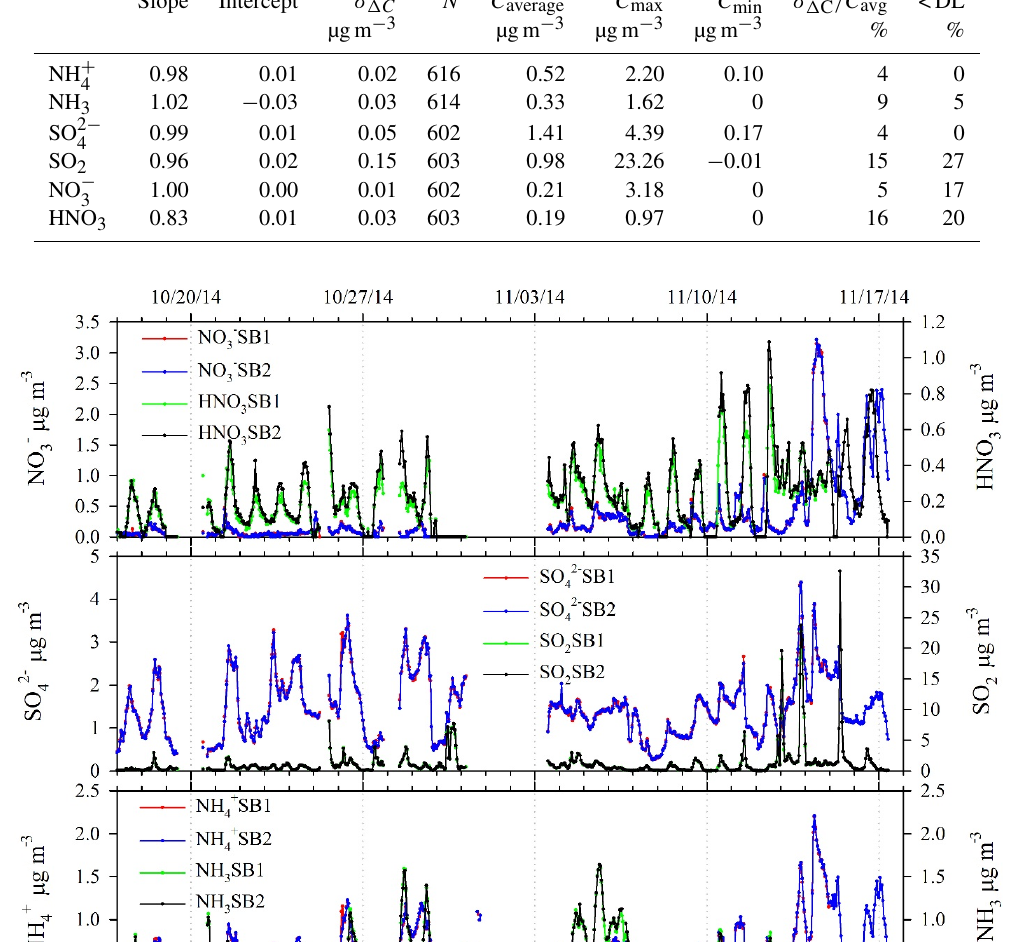
, SO 2 − and NH + and gas-phase HNO 3 , SO 2 and NH 3 3 4 4